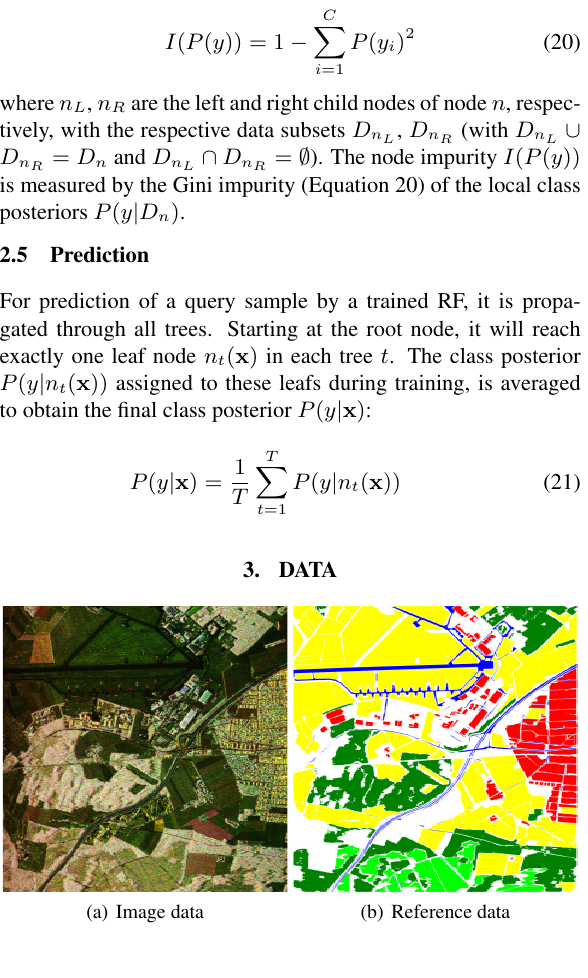
Figure 1. Image and reference data for the Oberpfaffenhofen data set (PolSAR image acquired by E-SAR, DLR).